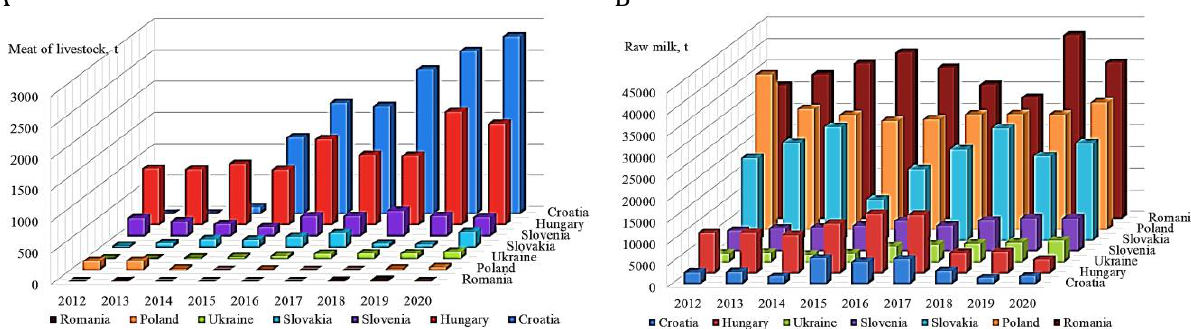
Fig. 4. Dynamics of organic A) beef production and B) Milk production volumes in Ukraine and the EU during 2012-2020